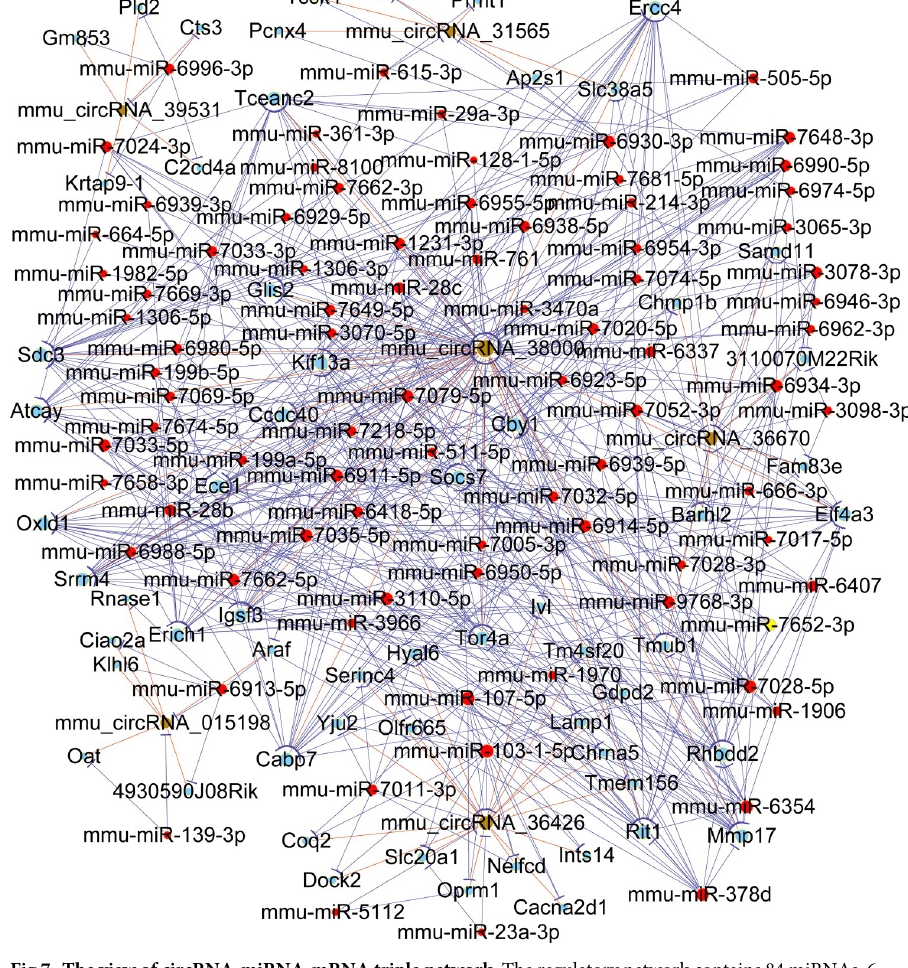
Fig 7. The view of circRNA-miRNA-mRNA triple network. The regulatory network contains 84 miRNAs, 6 circRNAs, and 60 mRNAs. The light-blue nodes represent mRNA, the red nodes represent miRNAs, and the brown nodes represent